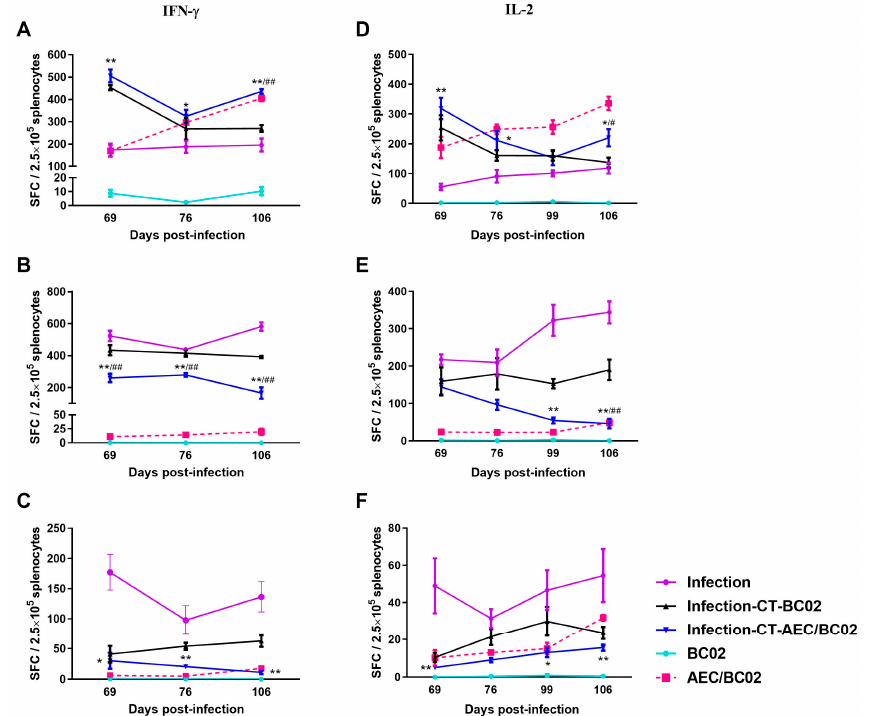
Figure 4. The frequency of spot-forming cells expressing IFN- γ or IL-2 was determined by ELISPOT. The magnitude of the IFN- γ -secretion response produced by stimulation of splenic lymphocytes in normal mice and Mtb latently infected mice with Ag85b ( A ), ESAT6 ( B ), and CFP10 ( C ) peptides. The secretion of IL-2 cells stimulated by Ag85b ( D ), ESAT6 ( E ), and CFP10 ( F ) peptides was detected in the splenocytes of the two mouse models. */** The infection-CT-AEC/BC02 group was compared with the infection group. # / ## The infection-CT-AEC/BC02 group was compared with the infection- CT-BC02 group. Statistical significance was set at */ # p < 0.05 or **/ ## p < 0.01 ( n = 5).